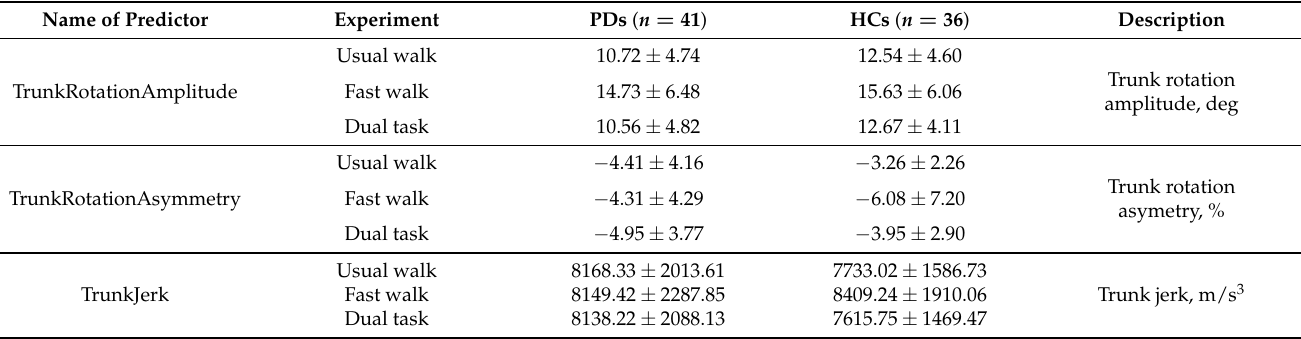
Table A1. Trunk-related predictors (mean and SD values, shown as mean ±